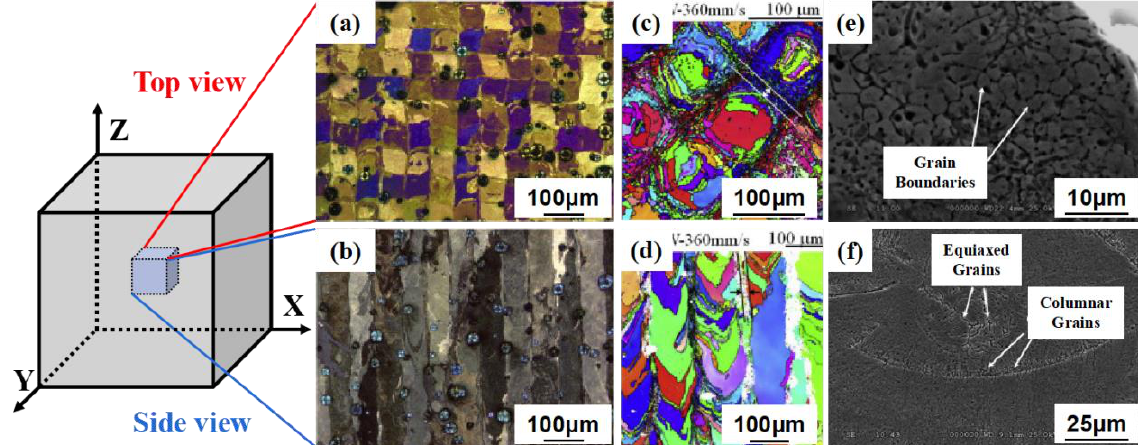
Figure 6. Grain morphology of Ni-Ti alloys formed by SLM parallel to and perpendicular to the depositing direction: ( a , b ) OM; ( c , d ) EBSD; ( e , f ) SEM [9–12].